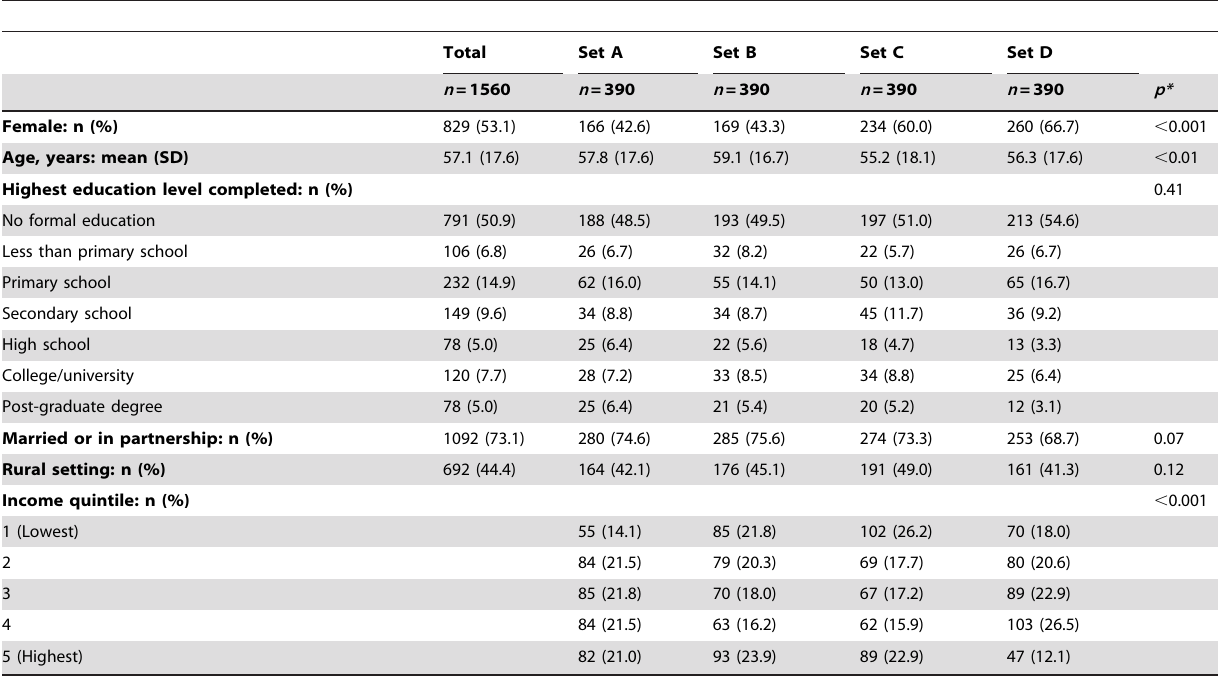
Table 1. Demographic characteristics of participants who completed sets A, B, C, or D in